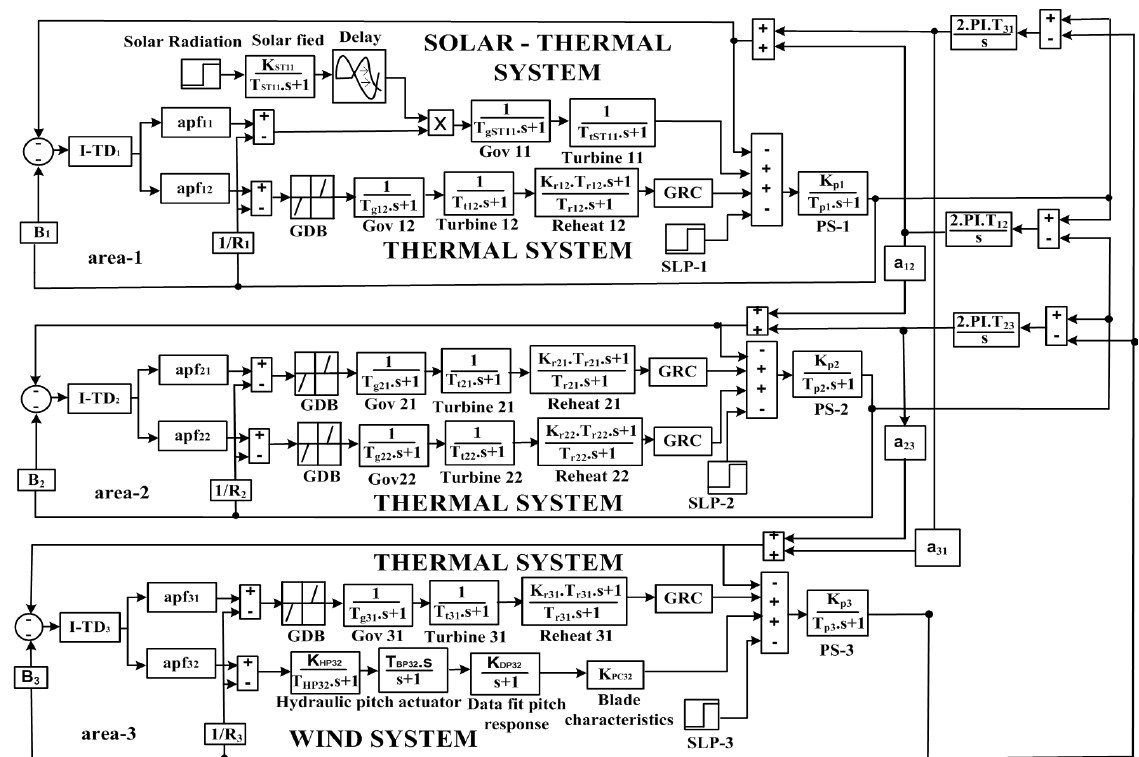
Figure 1 . Transfer function model of three-area multi-source